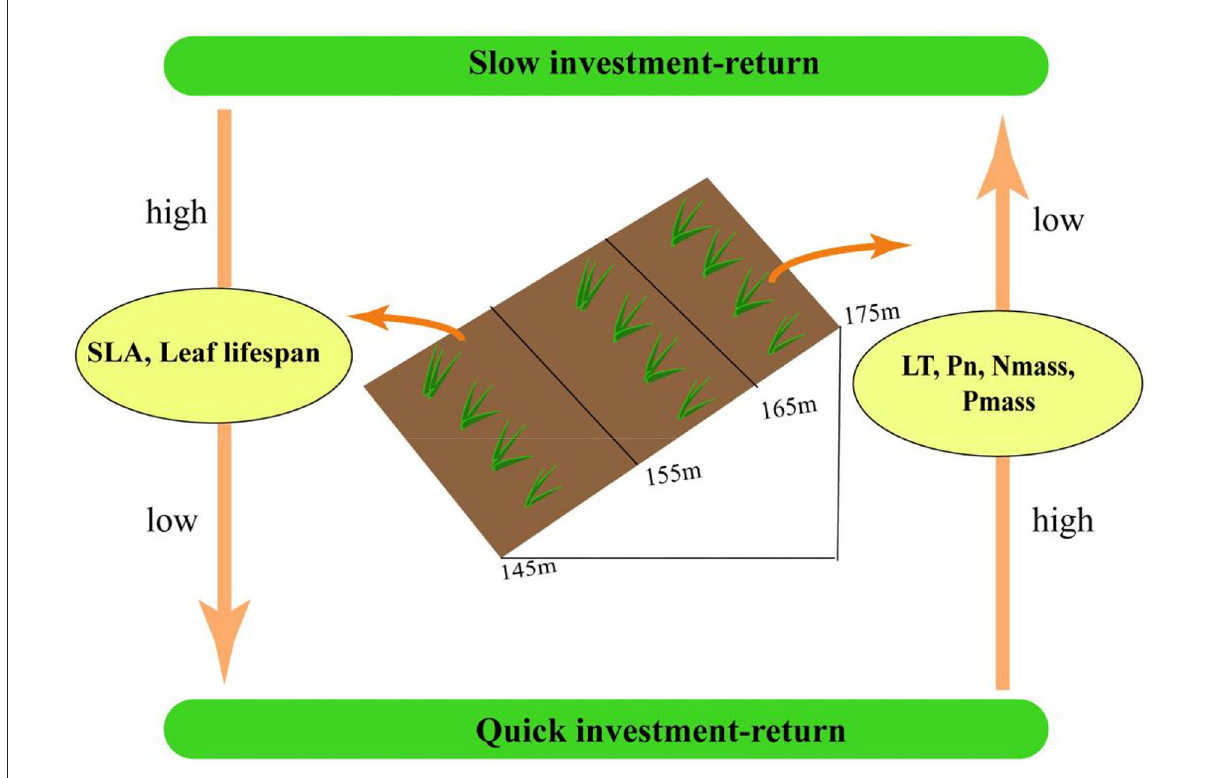
perennial plants are typical slow investment-return species (Figure 5). The position of plants in the leaf economics spectrum also indicates that plants can adjust their structure and physiological traits to adapt to different environmental gradients, and the emergence of leaf economics spectrum also provides a new perspective to explore the adaptability of